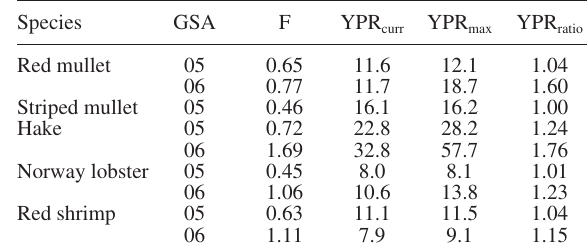
Fig . 4. – Dendrogram of the landings of the most important com- mercial species by fishing tactic (FT) from different ports of GSA05 (MA: Mallorca) and GSA06 (AM: Ametlla de Mar; BL: Blanes; DE: Denia; PS: Port de la Selva; LL: Llançà; PA: Palamós; RO: Roses; SC: Sant Carles de la Ràpita; SP: Santa Pola; TA: Tarragona; VI: Villajoyosa). SS: shallow shelf; DS: deep shelf; DS-PEL: pelagic deep shelf; US: upper slope; MS: middle slope; S-S: shelf-slope.